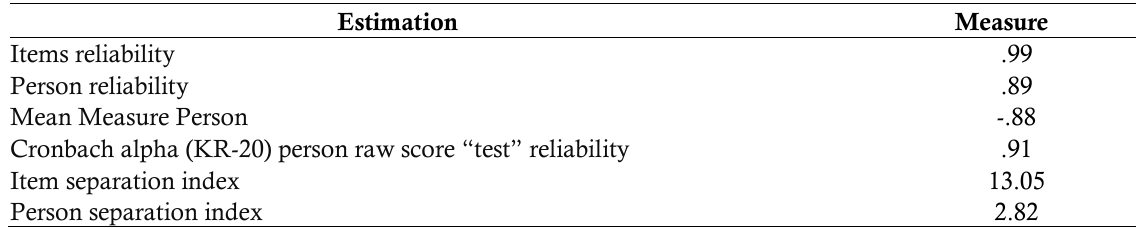
Table 1 . Summary